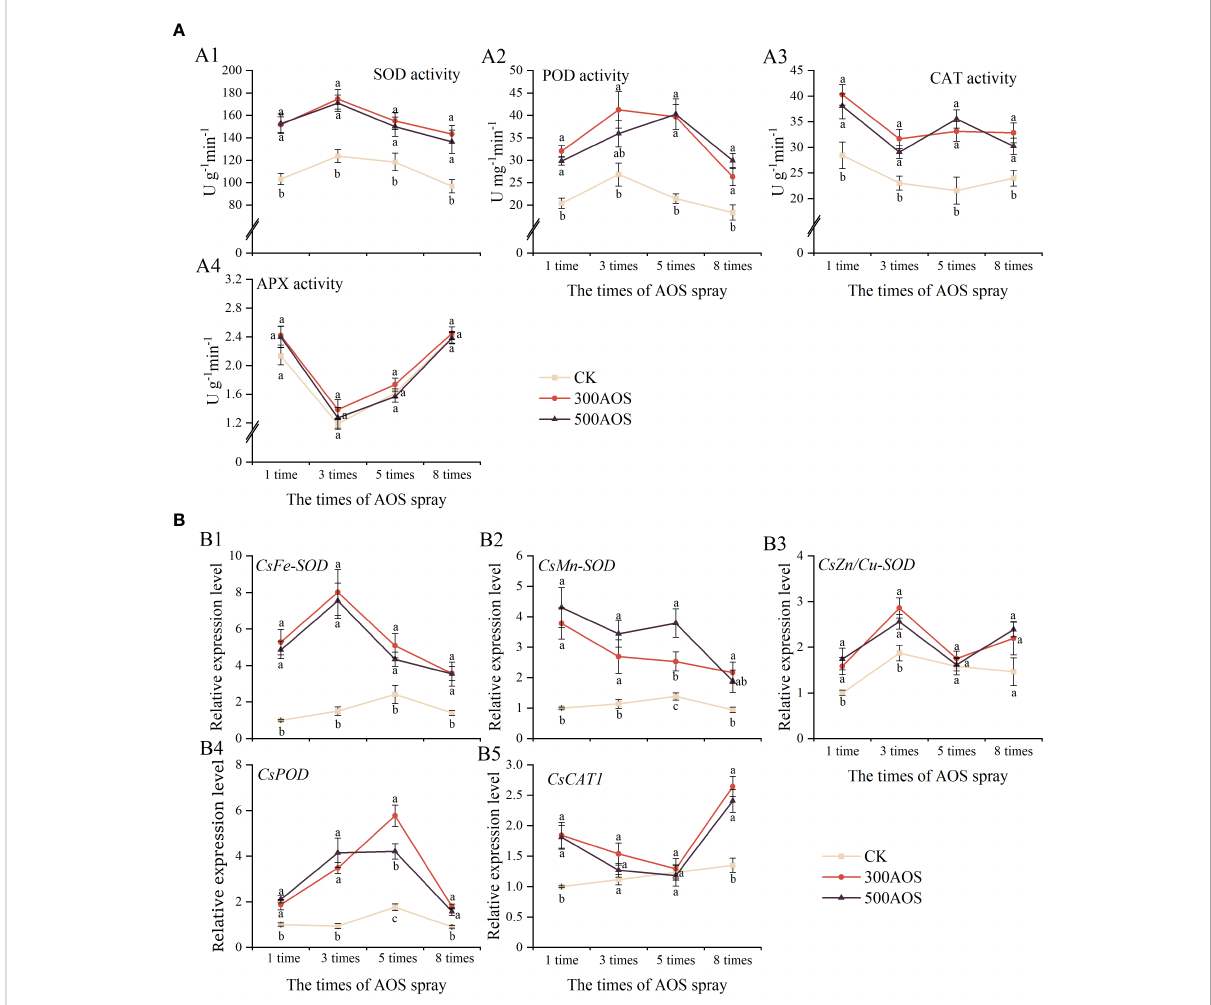
FIGURE 3 Effect of AOS treatment on the antioxidant system of citrus leaves. Antioxidant enzyme activity (A) , the expression of antioxidant enzyme-related genes (B) . Different lowercase letters indicate signi fi cant differences among the treatments, based on the Duncan test ( p < 0.05, n =